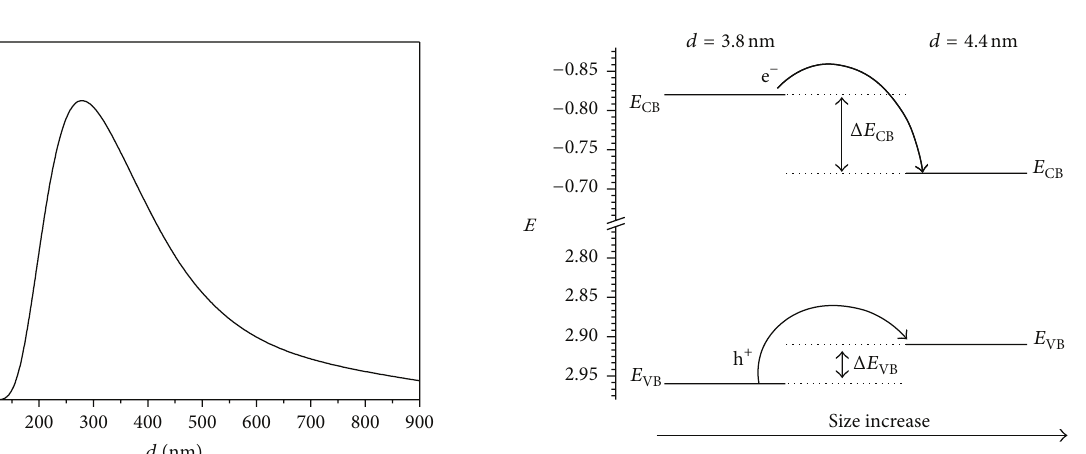
Figure 5: The energy diagram of ZnO nanoparticles of two different